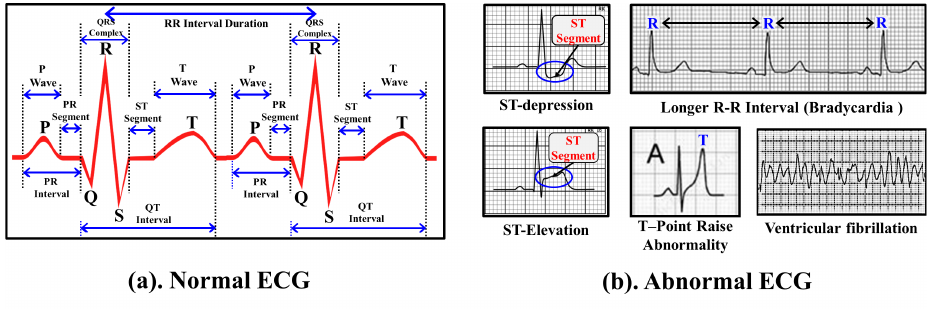
Figure 5. Various cardiac abnormalities in